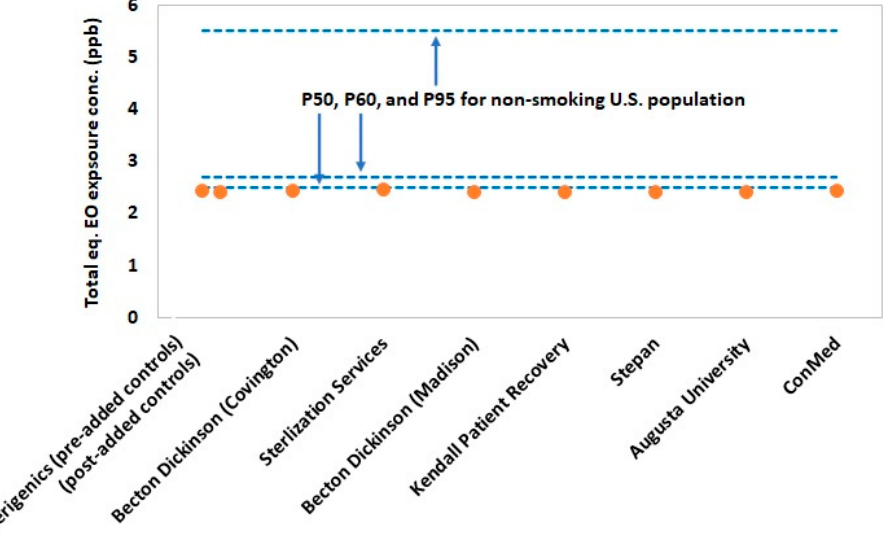
Figure 4. Estimated total equivalent exposure for the highest 5-year average modeled EO concentration for all residential receptors by facility ((50th percentile endogenous equivalent for the non-smoking U.S. population, or 2.3 ppb) + (50th percentile background EO concentration for Georgia, or 0.12 ppb) + (highest 5-year average modeled EO concentration for all residential receptors by facility)) relative to that of the 50th, 60th, and 95th percentiles of the non-smoking U.S. population (2.5, 2.7, and 5.5 ppb, respectively).